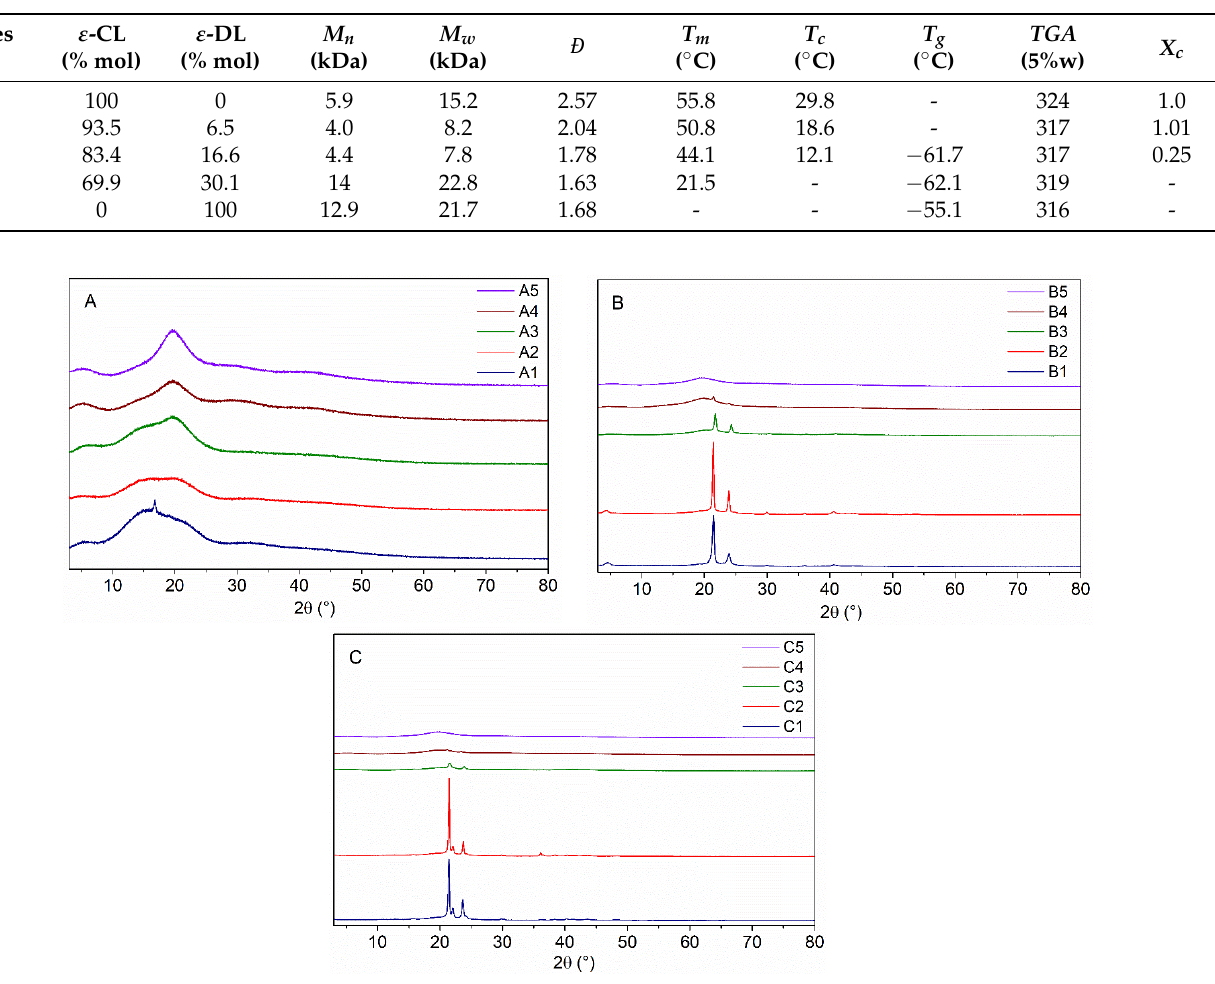
Figure 7. Diffractograms in Series I ( A ), Series II ( B ) and Series III ( C ).